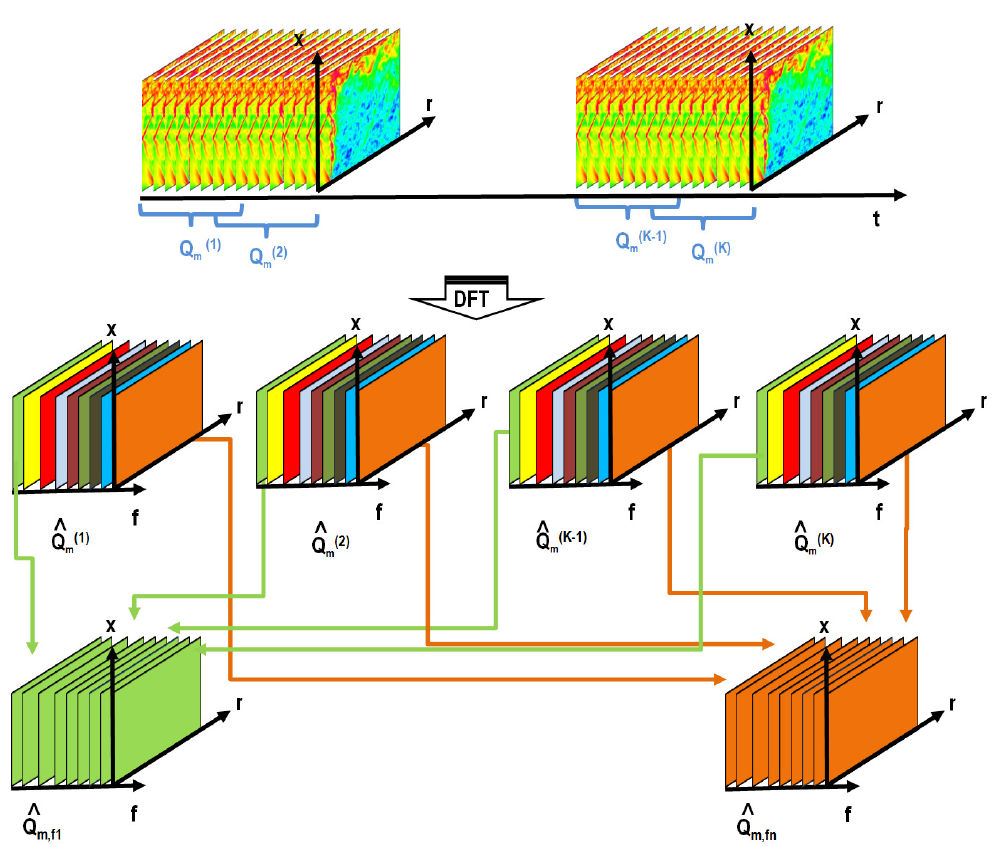
Figure 3. Schematic of estimating spectral proper orthogonal decomposition (SPOD) modes using Welch’s method (Colours represent discrete